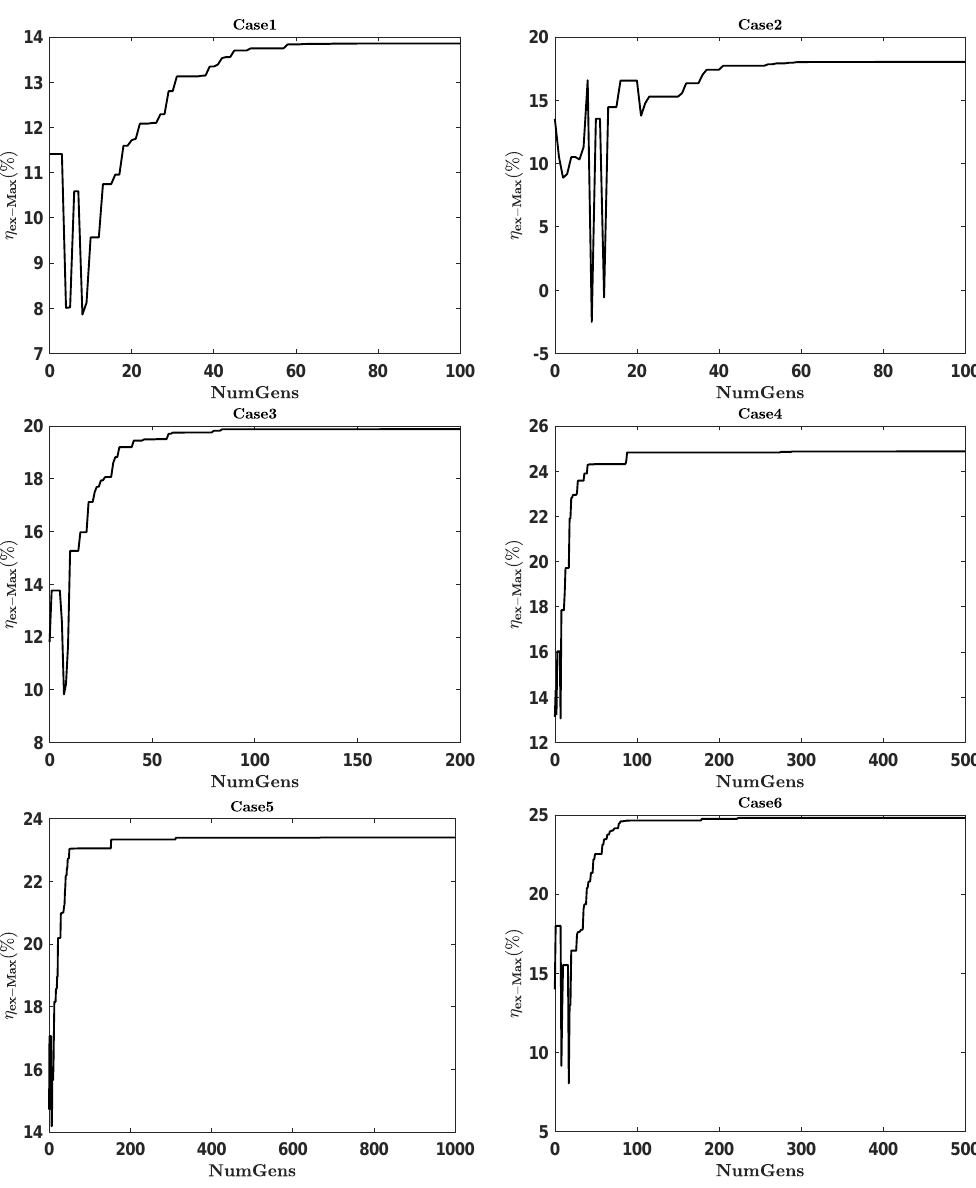
Figure 6. Evolution of the maximum exergy efficiency in each